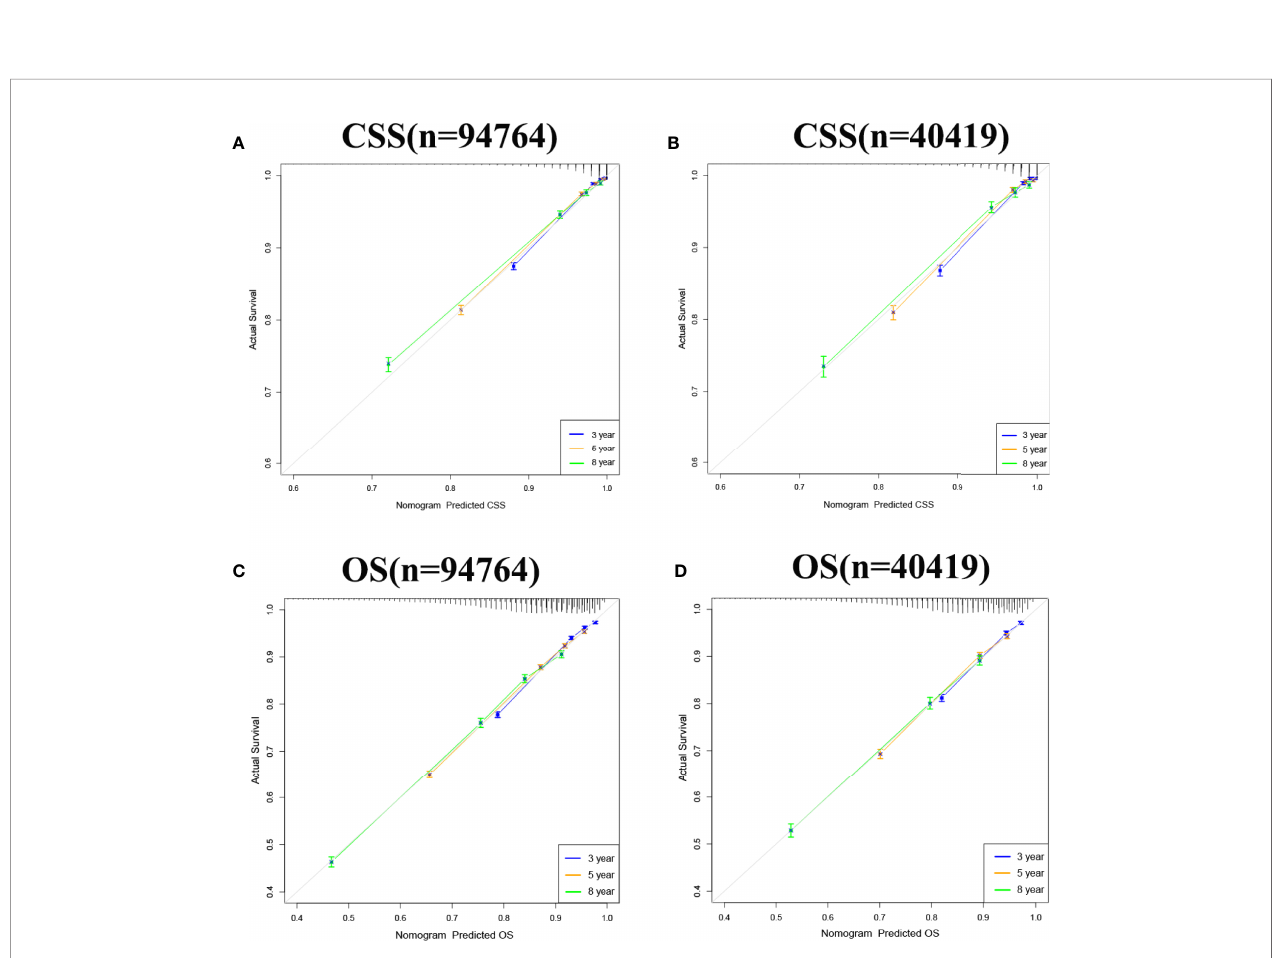
FIGURE 3 | Calibration curve of the nomograms for predicting 3-,5-,8-year CSS and OS in elderly patients with PC. (A) Calibration curve of the nomograms for predicting 3-,5-,8-year CSS in the training set. (B) Calibration curve of the nomograms for predicting 3-,5-, and 8-year CSS in the validation set. (C) Calibration curve of the nomograms for predicting 3-,5-,8-year OS in the training set. (D) Calibration curve of the nomograms for predicting 3-,5-,8-year OS in the validation set. The horizontal axis is the predicted value in the nomogram, and the vertical axis is the observed